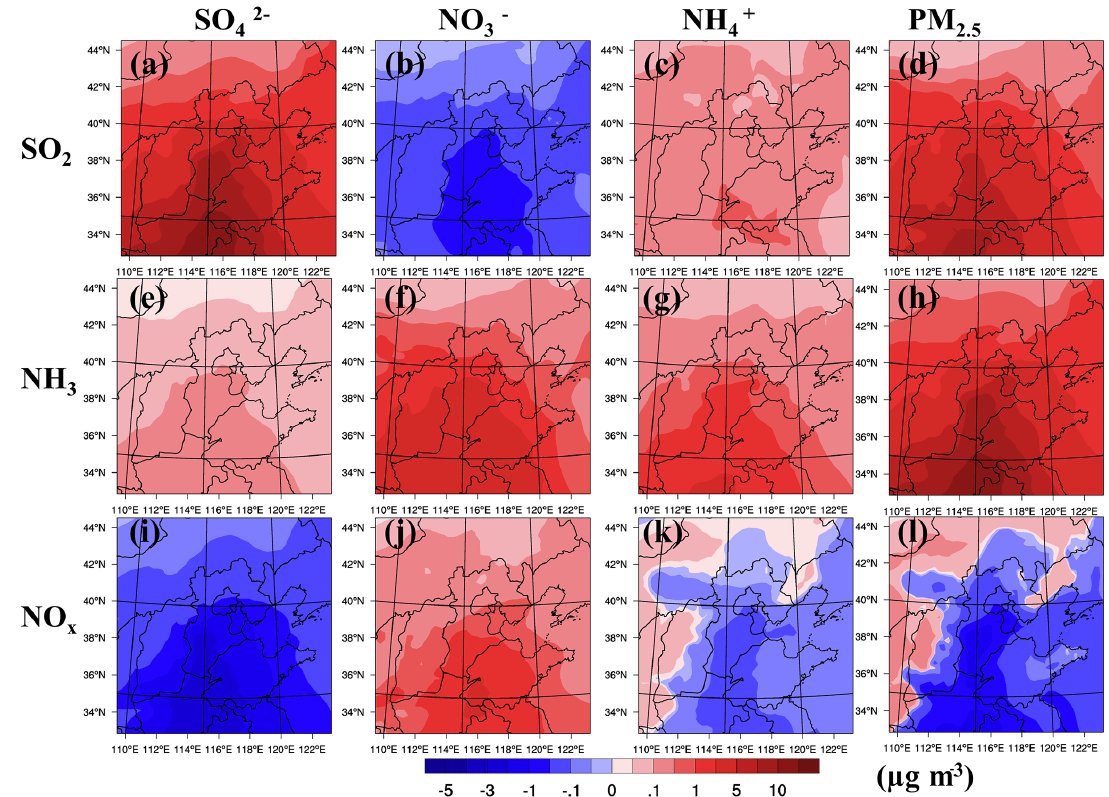
Figure 4. Responses of PM 2 . 5 and major PM 2 . 5 inorganic species (sulfate, nitrate, and ammonium) to individual changes in SO 2 , NH 3 , and NO x emissions from 1960 to